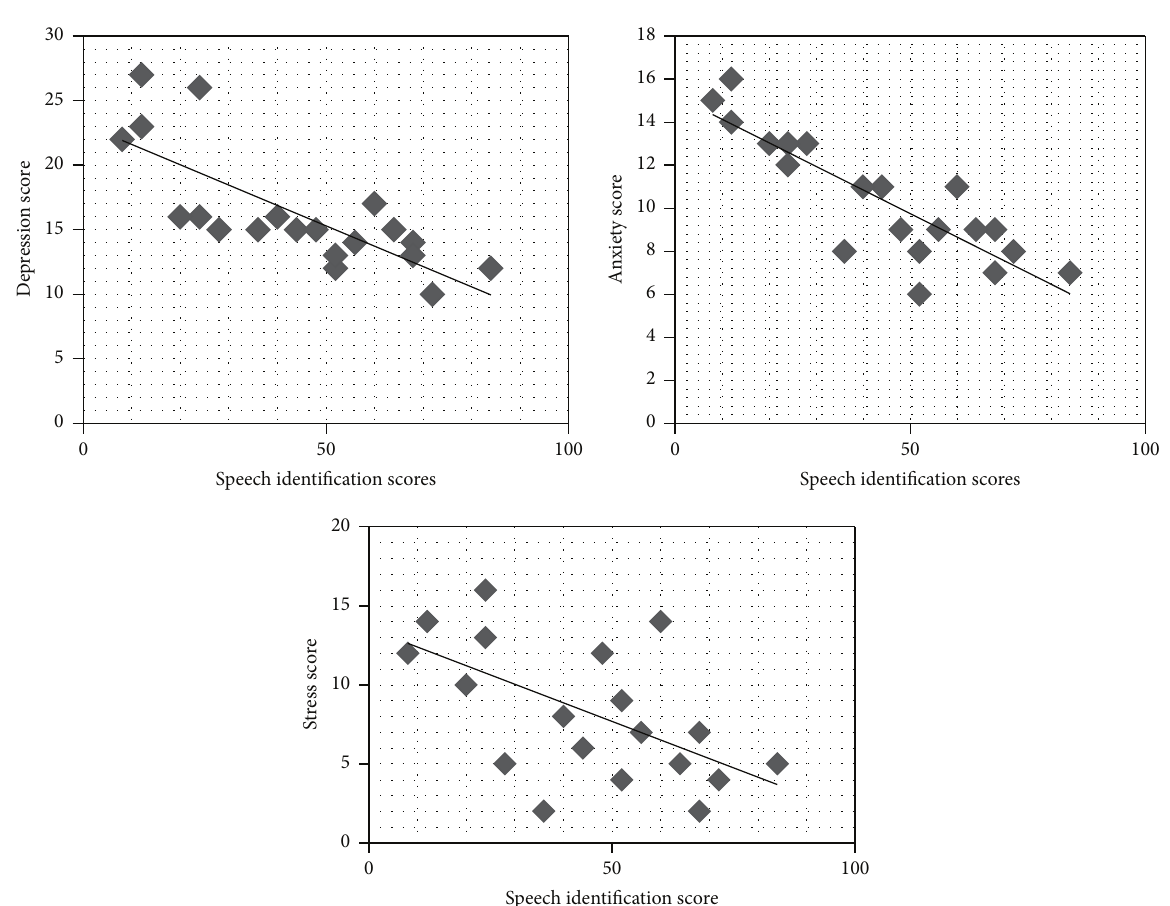
Figure 5: Scatter plots of correlation between the average speech identification scores and the different scales of